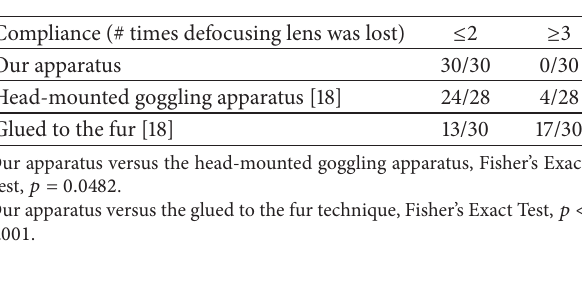
Table 2: A comparison of the reported apparatus stability and the head-mounted spectacle